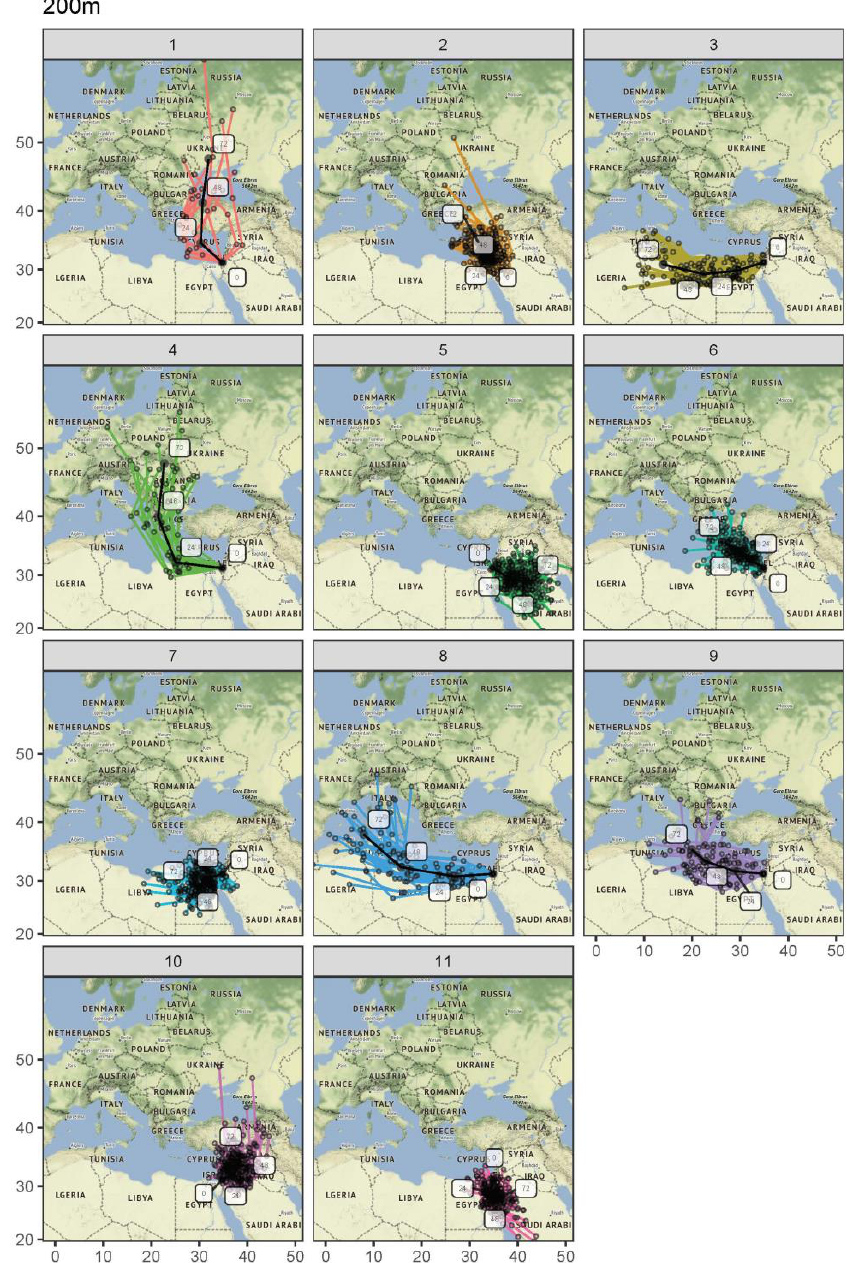
Figure 3. The 72-h back trajectory clusters at 200 m. Colored lines represent individual back trajectories for each dust day, and black lines depict the average coordinates for each cluster. Among the remaining clusters at 200 m, Cluster 8, which was also associated with very high levels of PM 10 (332.6 µg/m 3 ), had a similar pattern to Cluster 4 but was situated further west. Here,